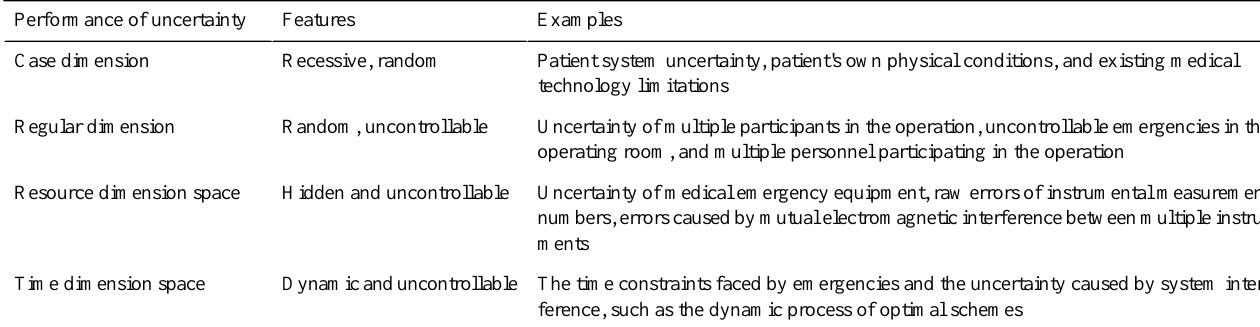
Table 1. Uncertainty in cardiac emergency decision making. ExamplesFeaturesPerformance of